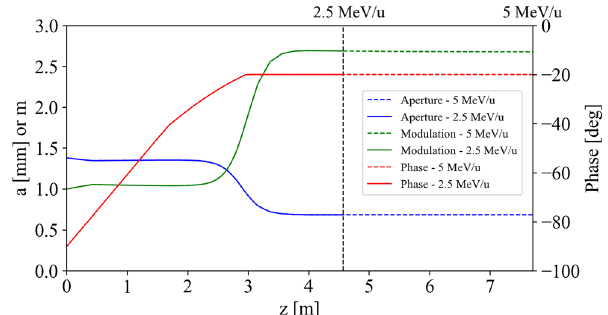
FIG. 4. Modulation, synchronous phase, and minimum aperture of the high transmission RFQ are plotted for the two final energies of 2.5 MeV/u (solid line) and 5 MeV/u (dashed